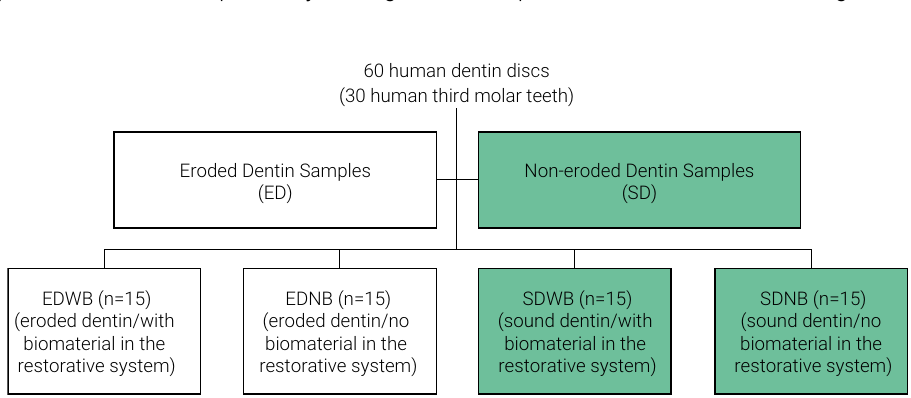
Figure 1. Fluxogram of samples’